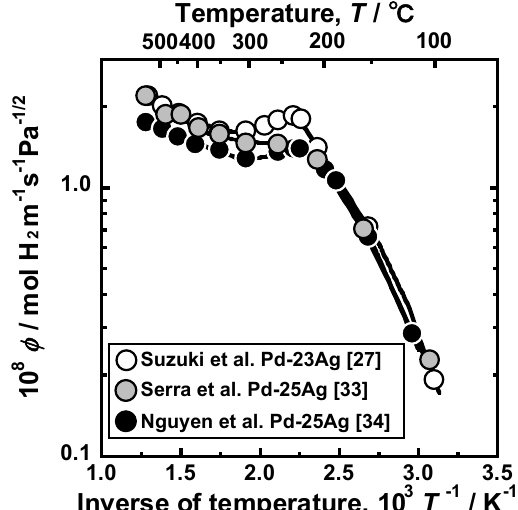
Figure 9. Arrhenius plot of hydrogen permeation coe ffi cient ( φ ) of Pd–23 mol%Ag alloy membrane [27]. The temperature dependence of hydrogen permeation coe ffi cients of Pd − 25 mol%Ag reported in the literature [33,34] is also shown in the figure.